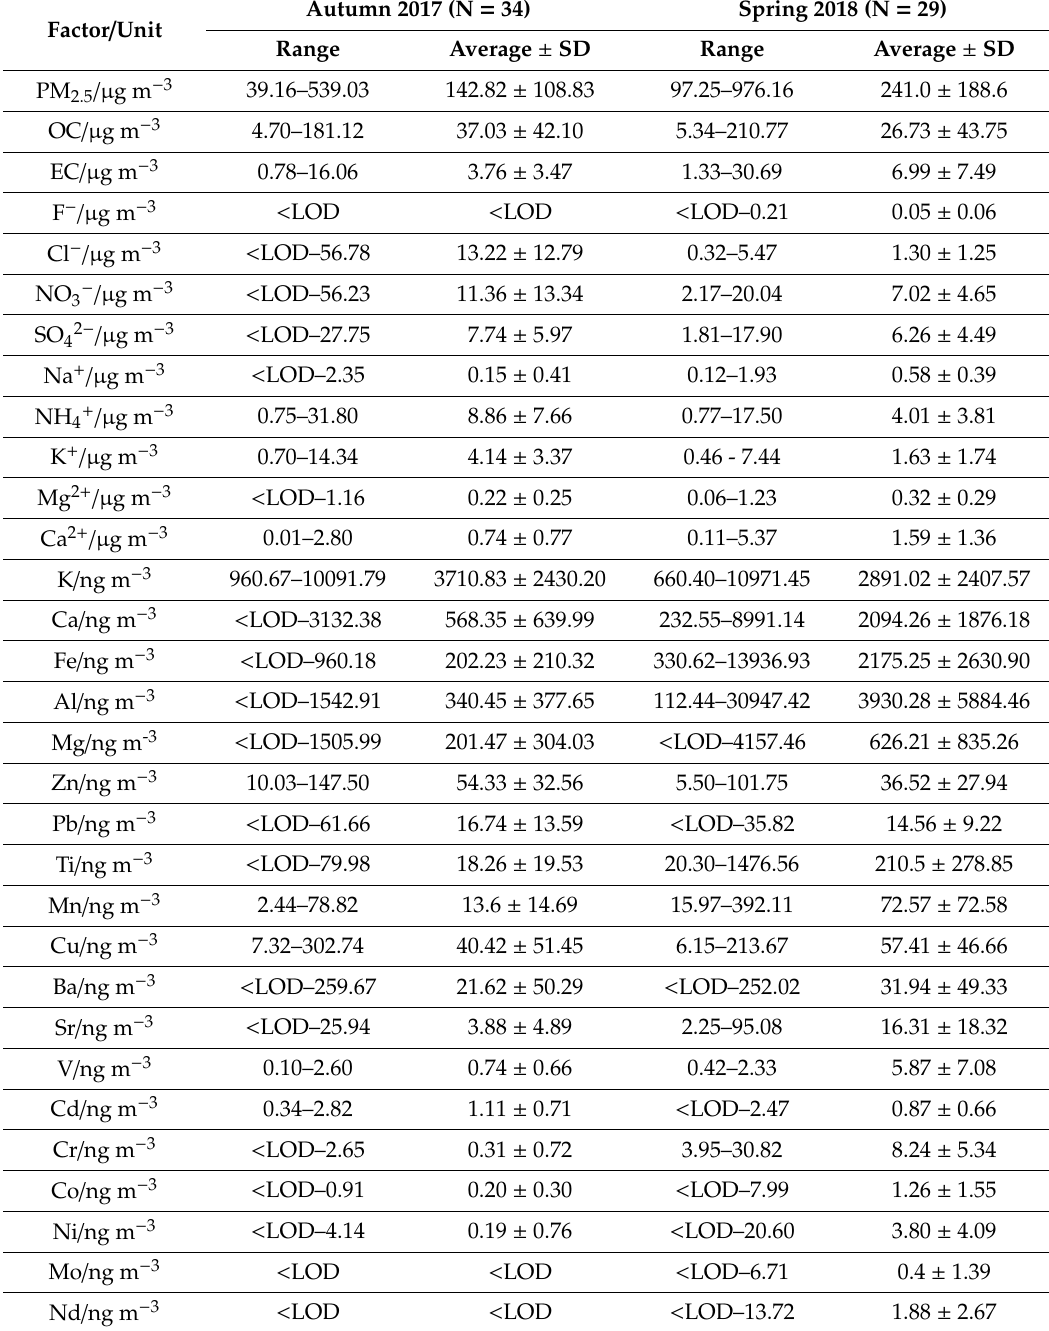
Table 1. Monthly average concentrations of PM 2.5 , OC, EC, water-soluble ions, and trace elements at the investigated rural site, Northeast